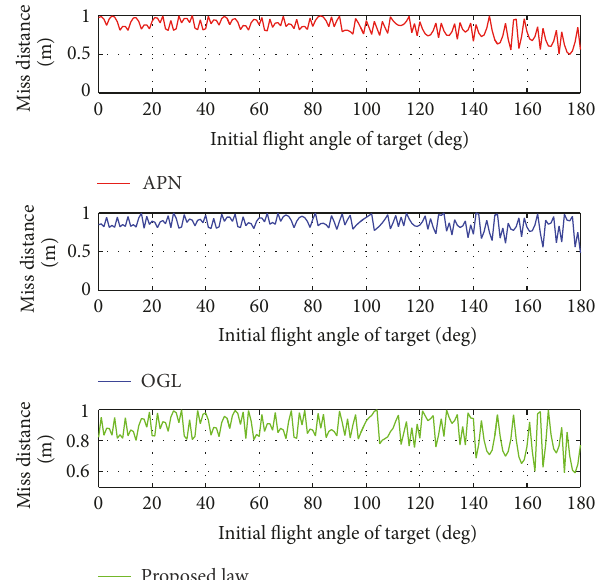
Figure7:FinalmissdistanceofAPN,OGL,andproposedlawunder different initial flight angel of target.